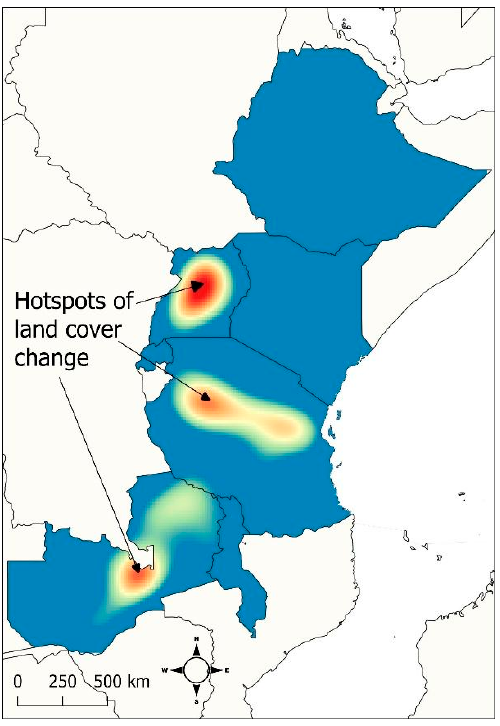
Figure 12. Three primary hotspots of land cover conversion, as calculated using kernel density estimation. This figure combines each type of land cover conversion analyzed in this study.